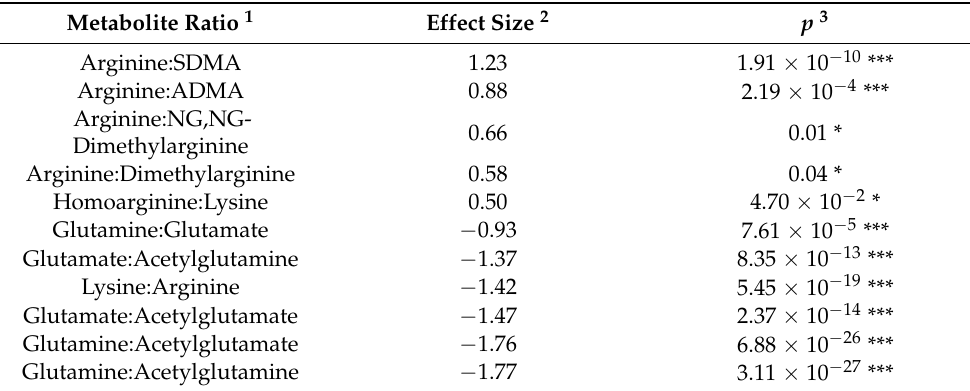
Table 3. Key metabolite ratios in the arginine-NO pathway with significant differences between dinner and